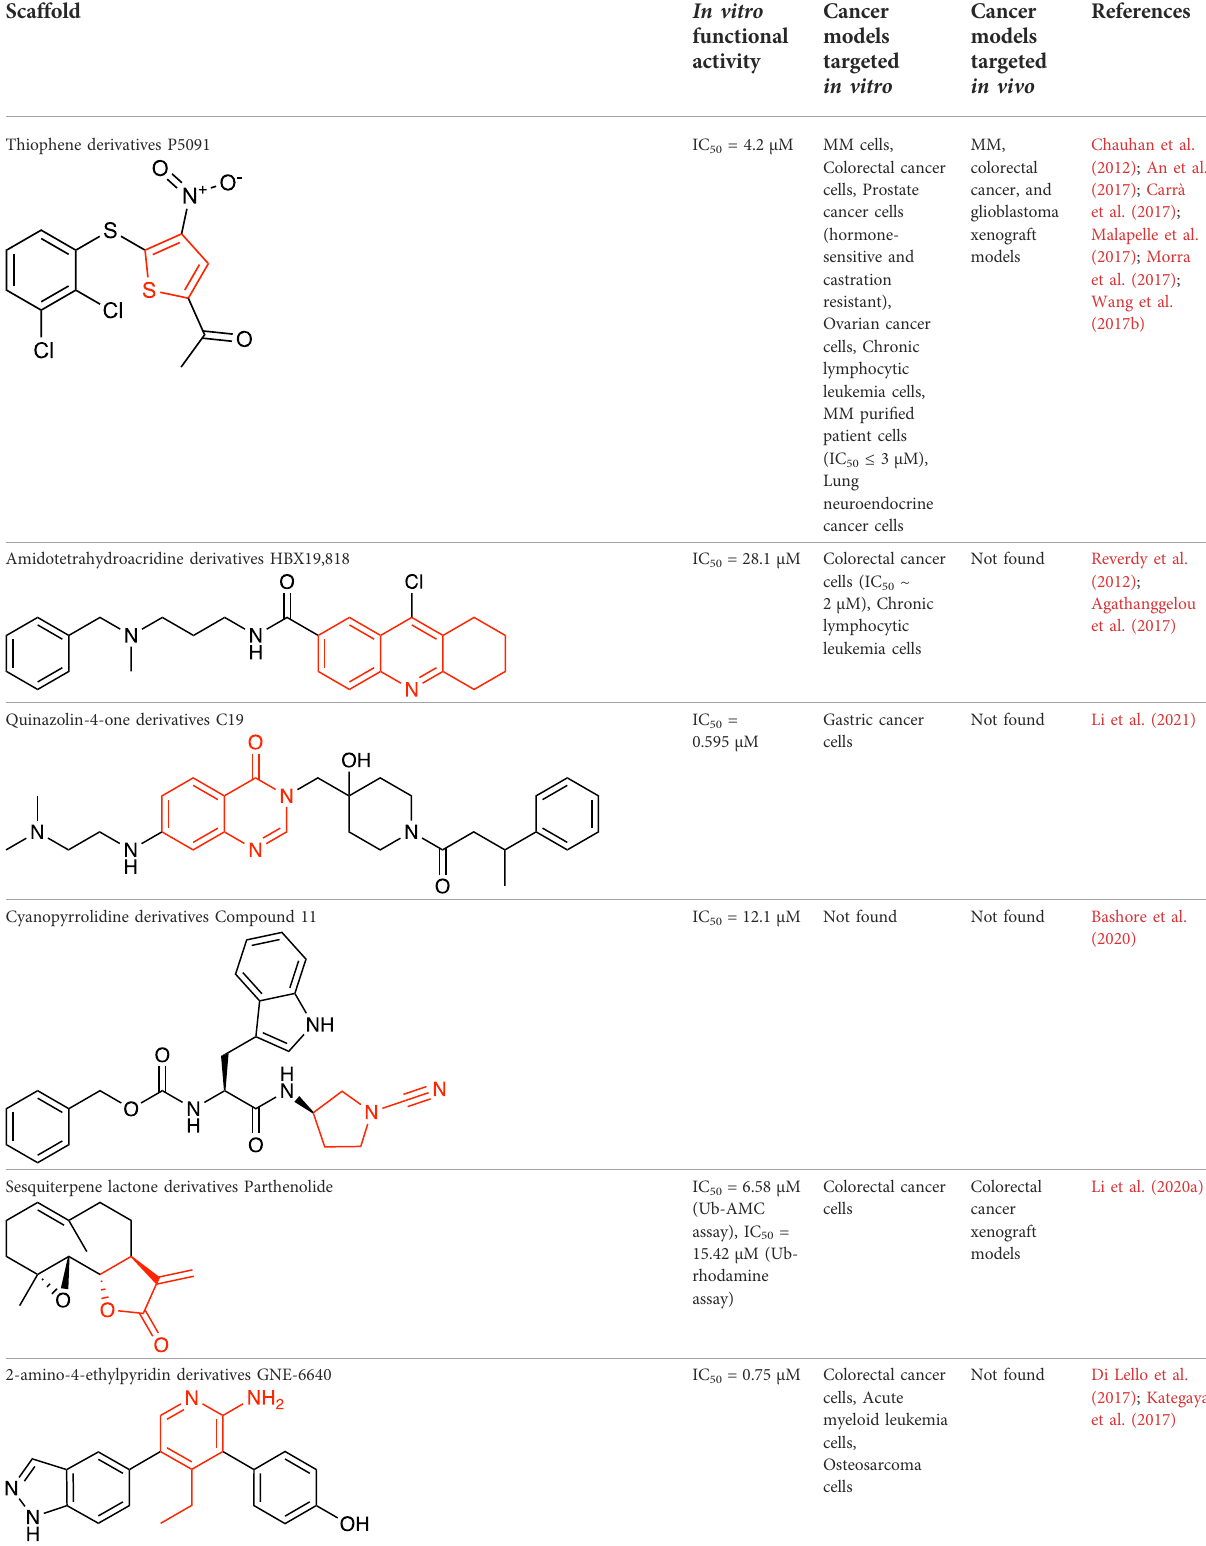
TABLE 1 Representative structures of the most potent USP7 inhibitors scaffolds.